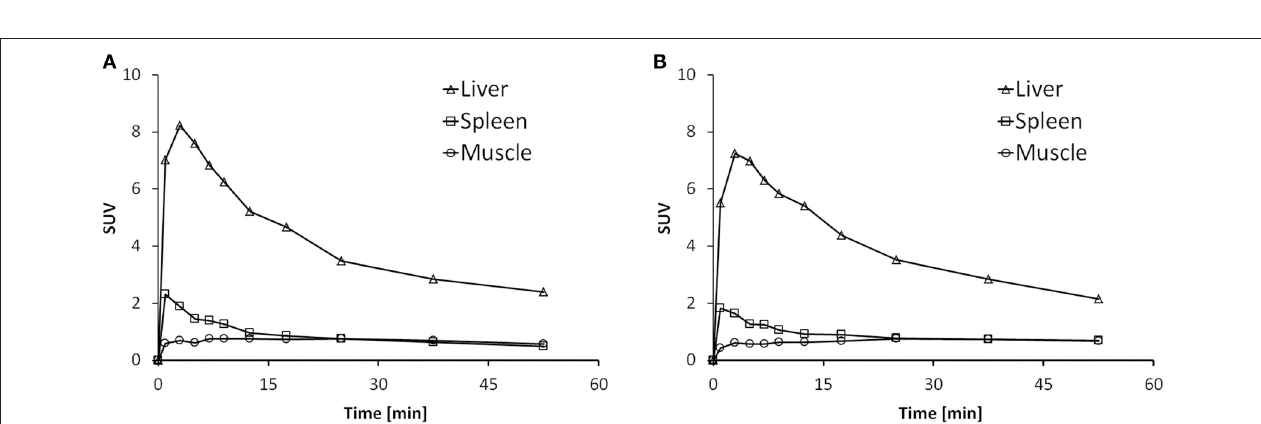
FIGURE 5 | Rat spleen PET/CT images after injection of [ 11 C]AAT-015 (averaged 0–60 min post injection). (A) Coronal and axial slices of the abdominal region. Spleen is encircled in the CT and PET/CT images, demonstrating low uptake of [ 11 C]AAT-015. SUV max = 4. (B) Maximal intensity projection (MIP) images of the abdominal region under baseline (same rat as in A ) and blockade conditions (injection of 1.5 mg/kg GW405833 shortly before radiotracer). Spleen is encircled. Li, liver; Ki, kidney; Int, intestine. SUV max = 6.